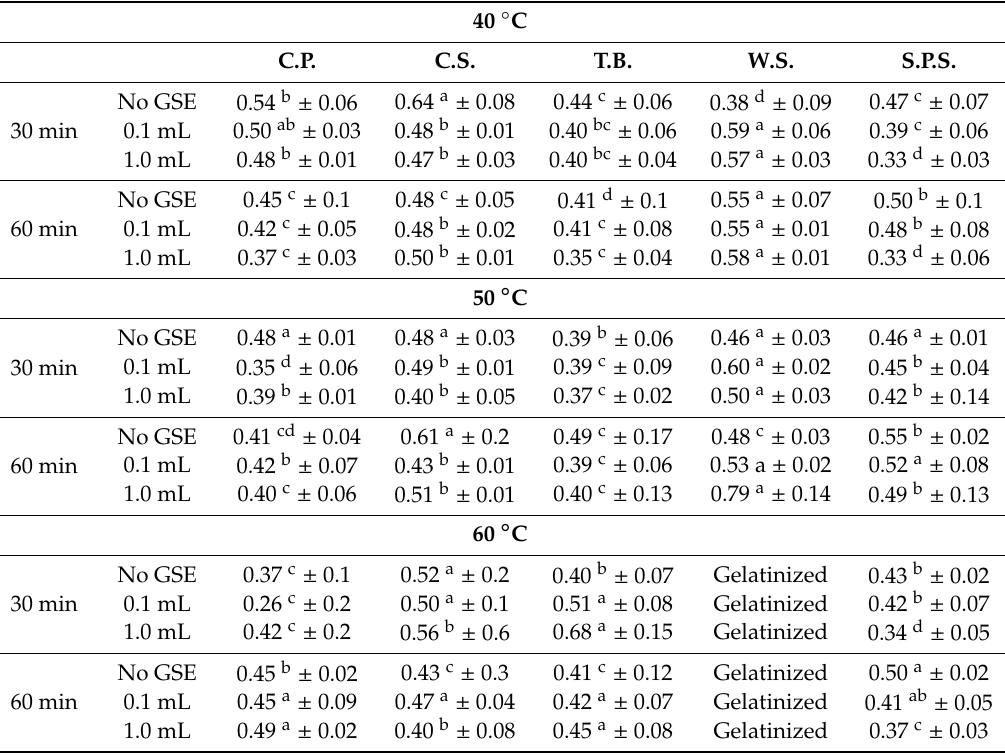
Table 5. The e ff ect of germinated sorghum extract (GSE) on starch gel